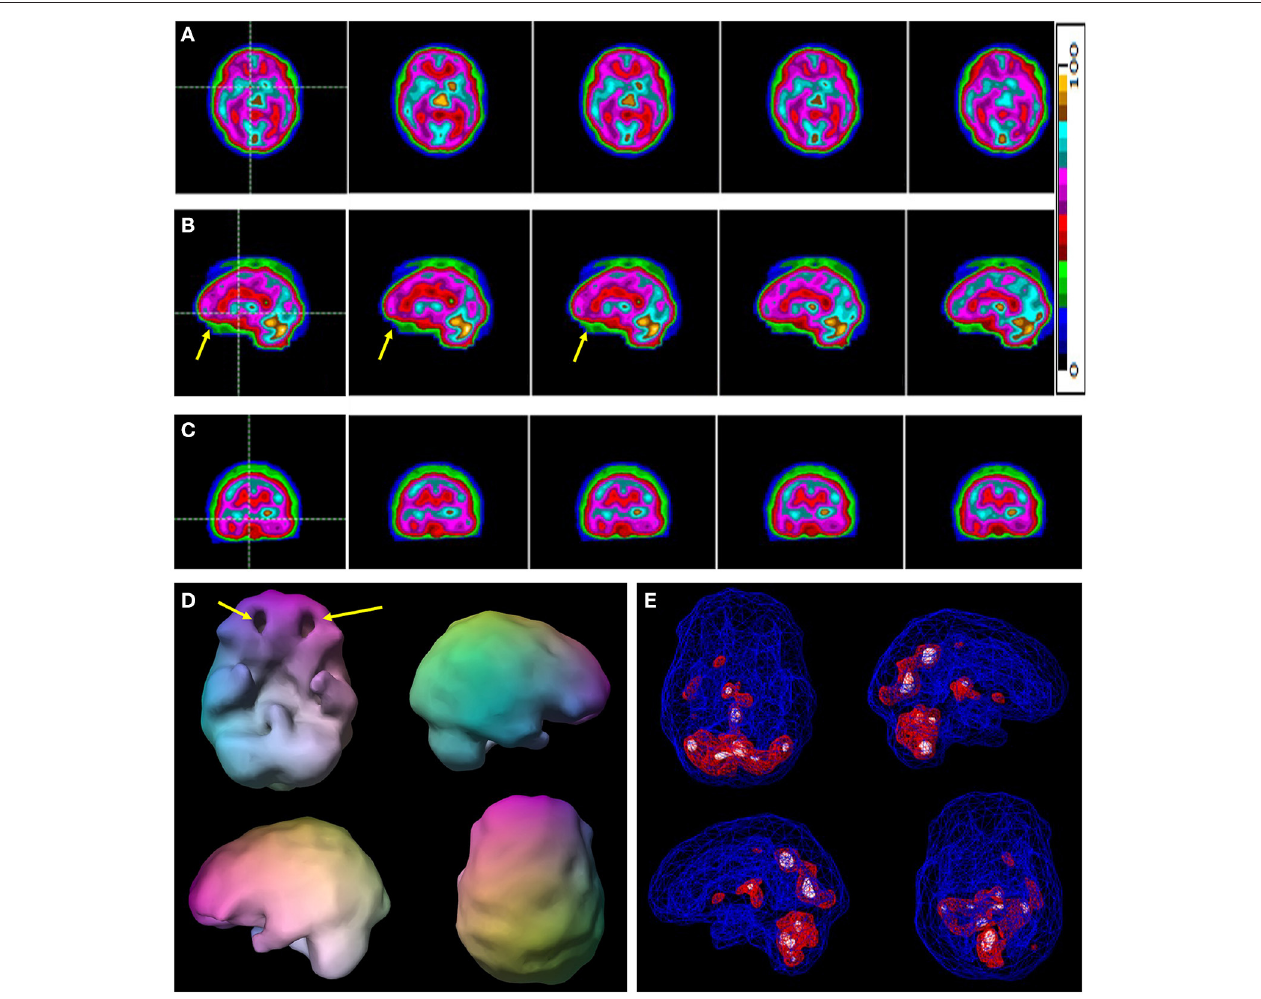
FIGURE 2 | A typical example of a case of ADHD without comorbidity. Selected tomograms in horizontal (A) , sagittal (B) , and coronal (C) orientation are provided. The color scale is the same as Figure 1 for the tomograms is provided. All voxels are scaled to the brain maximum and assigned each a color gradient based on its percentile of activity. Each color step represents a (not necessarily linear) five-percentile-point change in rCBF. Yellow arrows indicate areas of hypoperfusion in the orbitofrontal cortices. (D) A 3-D representation of the scan data is shown. The surface setting is the same as in Figure 1 . Yellow arrows point to the areas of decreased perfusion in the orbitofrontal cortices. (E) A wireframe brain representation is shown with setting the same as in Figure 1